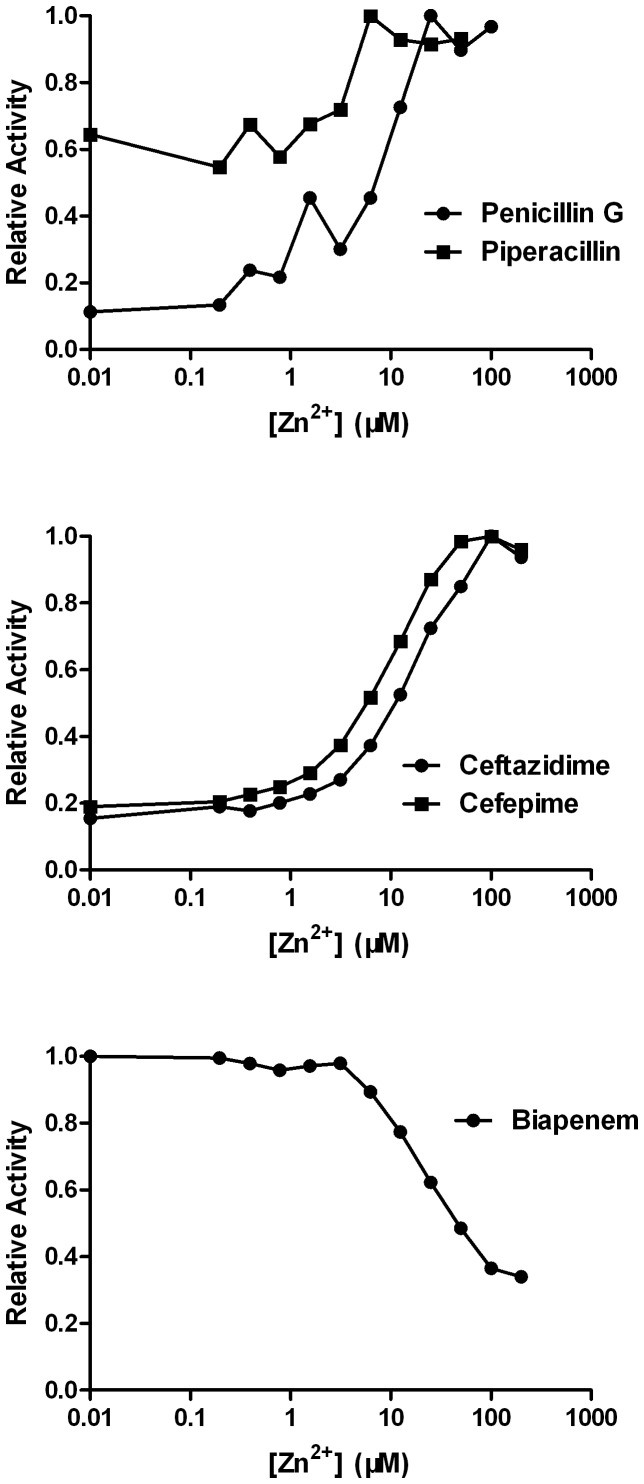
Zinc dependence of the NDM-1-catalyzed hydrolysis of various substrates.Measurements were made with 0.5 mM substrates and increasing ZnSO4 concentrations in the assay solution. Penems: penicillin G and piperacillin. Cephems: cefepime and ceftazidime. Carbapenem: biapenem.